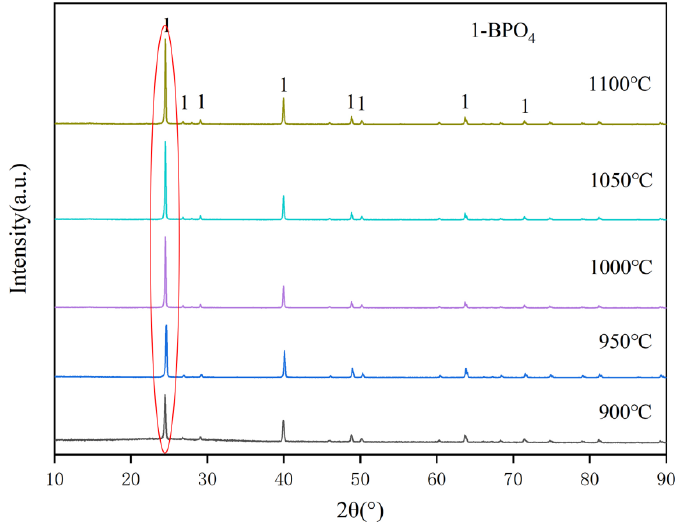
Figure 3. XRD patterns of B1.3 treated at 900~1100